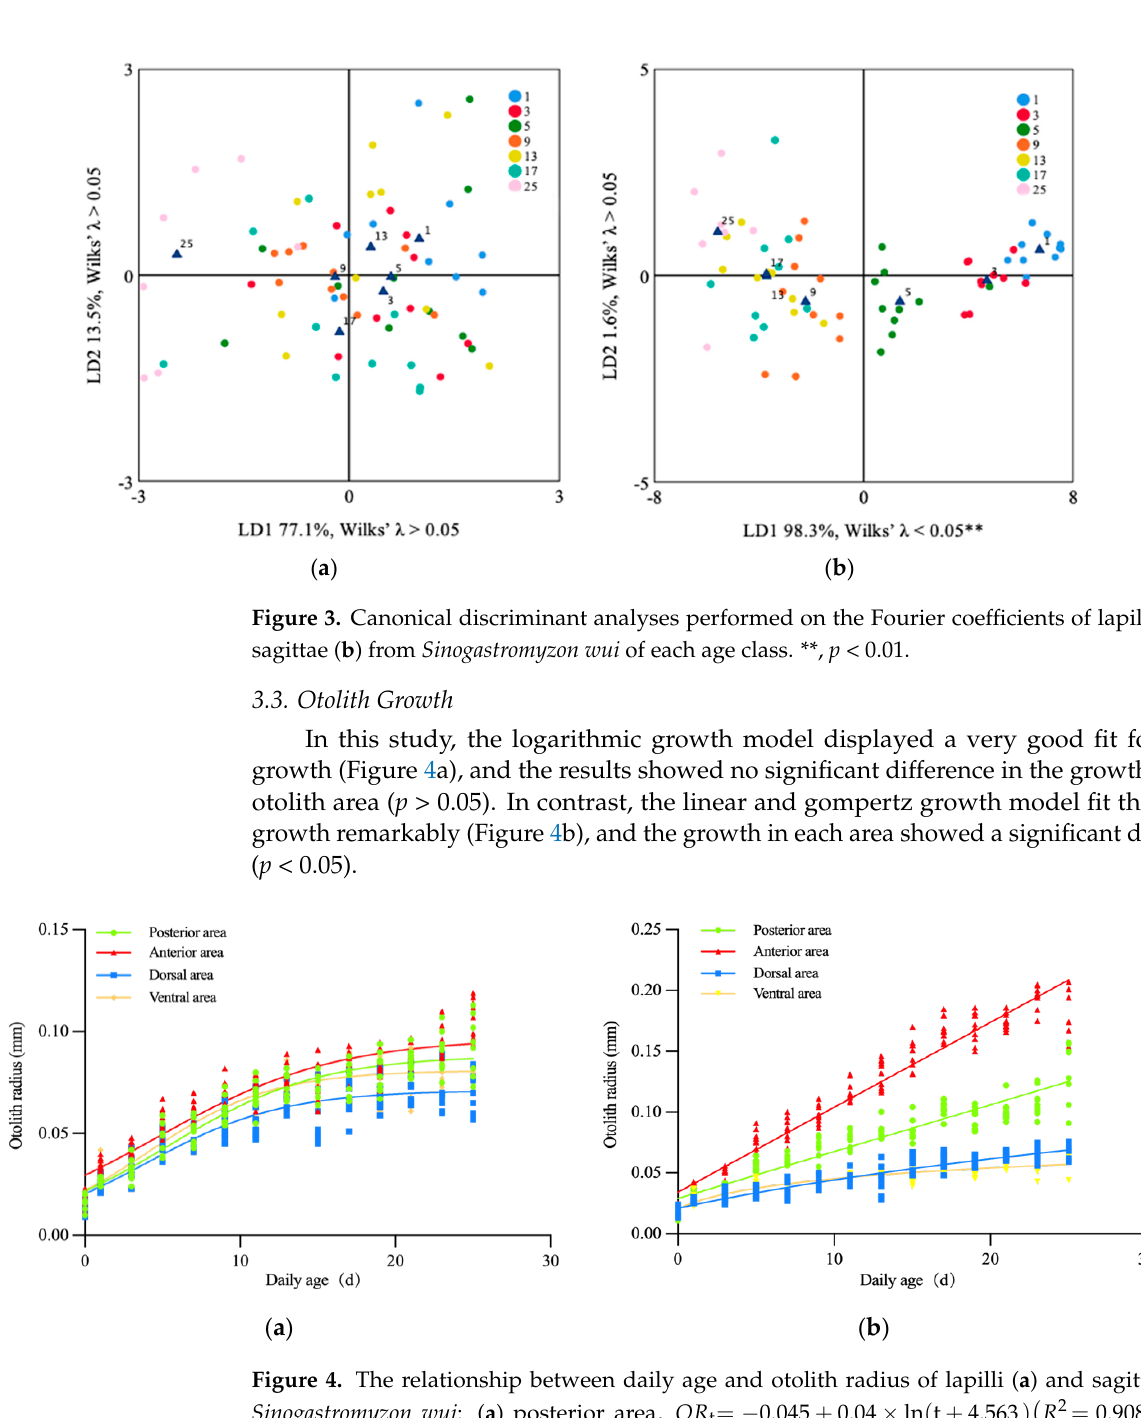
OL S = 5.089e 2.548 TL ( R 2 = 0.845, n = 150) (Figure